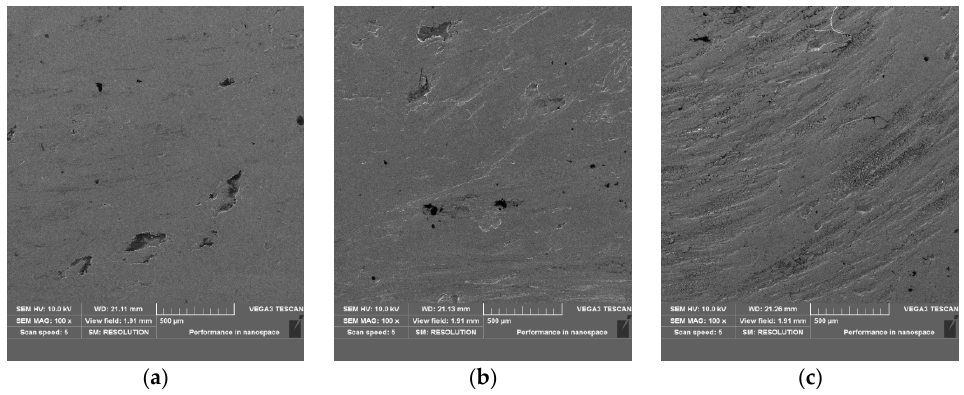
Figure 7. The worn surface morphology of shims after engine bench test (SEM): ( a ) 350 h, ( b ) 700 h, ( c ) 1000 h.